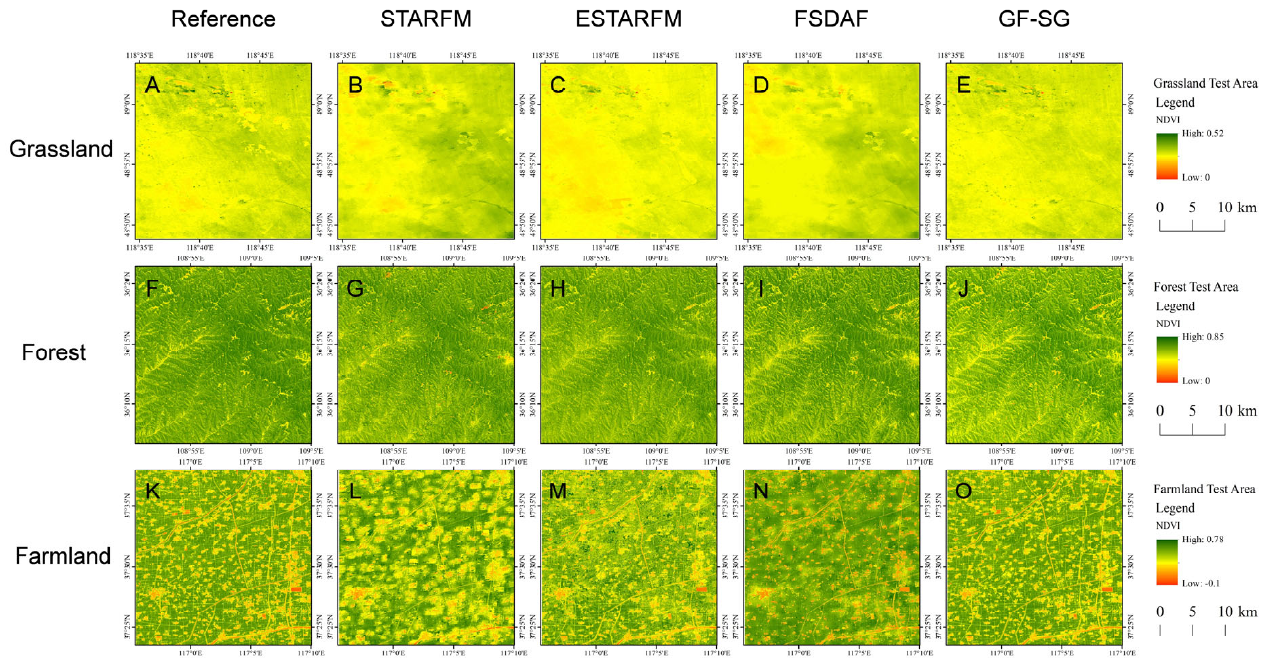
Figure 4. Reference images and fusion results. A–E are grassland test areas: A, reference image; B–E are the results of STARFM , ESTARFM, FSDAF, and GF ‐ SG, respectively. F–J are forest test areas: F, reference image; G–J are the results of STARFM , ESTARFM, FSDAF, and GF ‐ SG, respectively. K–O are farmland test areas: K, reference image; L–O are the results of STARFM , ESTARFM, FSDAF, and GF ‐ SG, respectively.